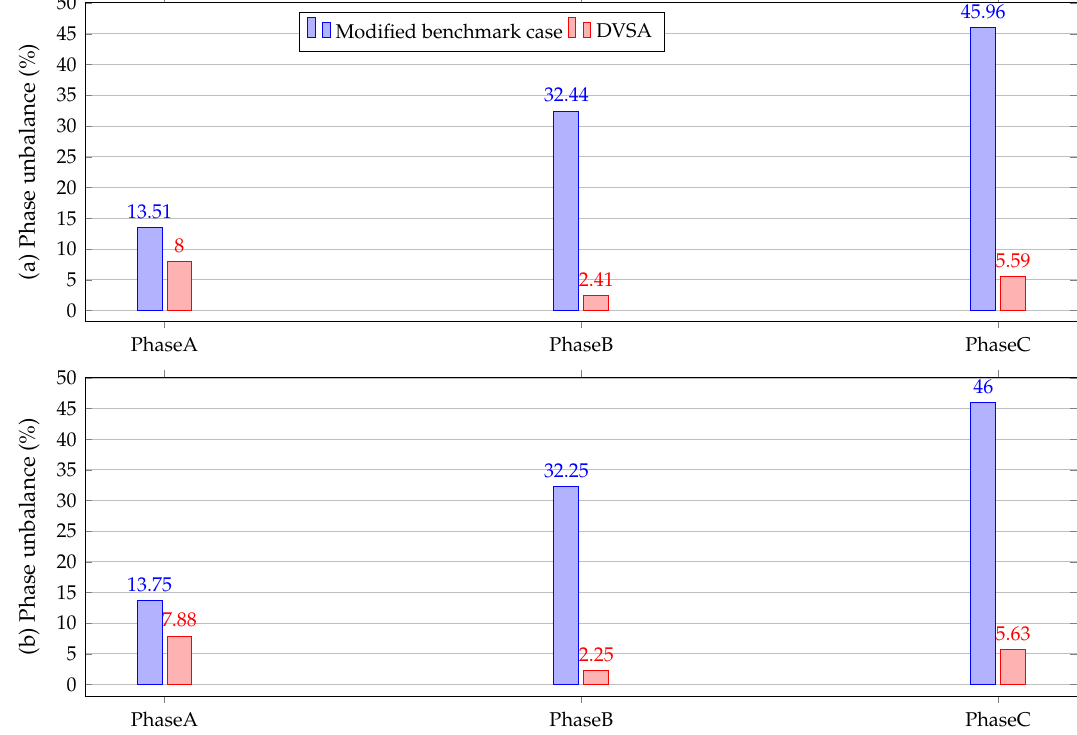
Figure 12. Unbalanced percentage for the 8-node test system: ( a ) active power and ( b ) reactive power.